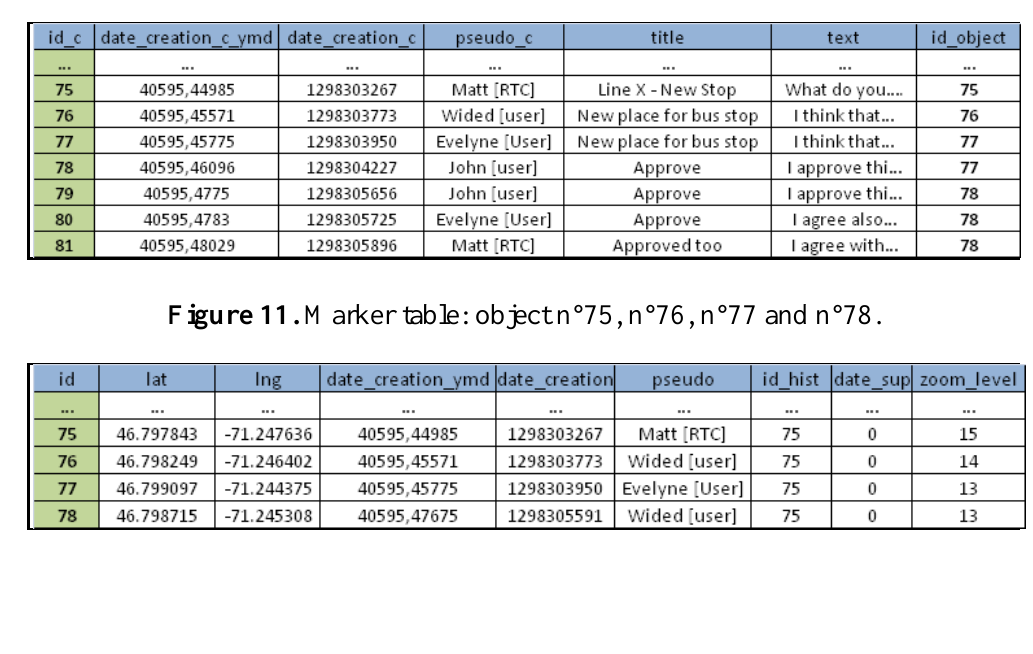
Figure 10. Comment table: object n°75, n°76, n°77 and n°78.